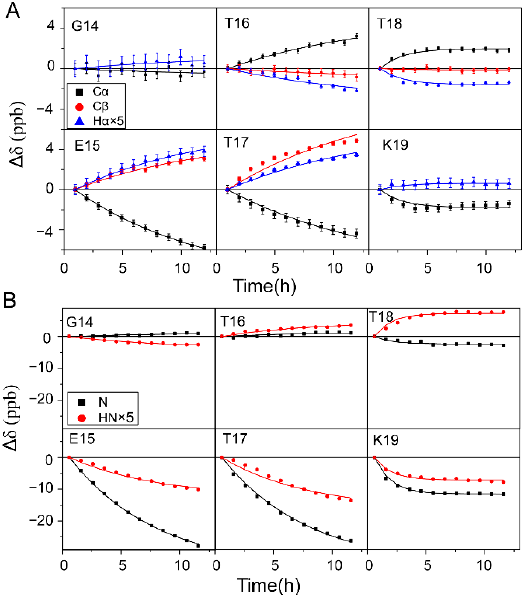
Figure 2. Chemical shift changes ∆ δ s ( δ t − δ t 0 ) of 1 H α , 13 C α , and 13 C β ( A ) and 1 H N and 15 N ( B ) as a function of H/D exchange time. The magnitude of 1 H α and 1 H N ∆ δ is multiplied by a factor of 5 to give a better view. ∆ δ s of residues G14 (E15), T16 (T17), and T18 (K19) were fitted to the H/D exchange rates of I7, L5, and Y3, respectively, using Equation (1). The C β chemical shift of K19 cannot be retrieved due to signal overlap. The error bars are from duplicate experiments. The ∆ δ s of all other residues are shown in Figures S2 and S3.